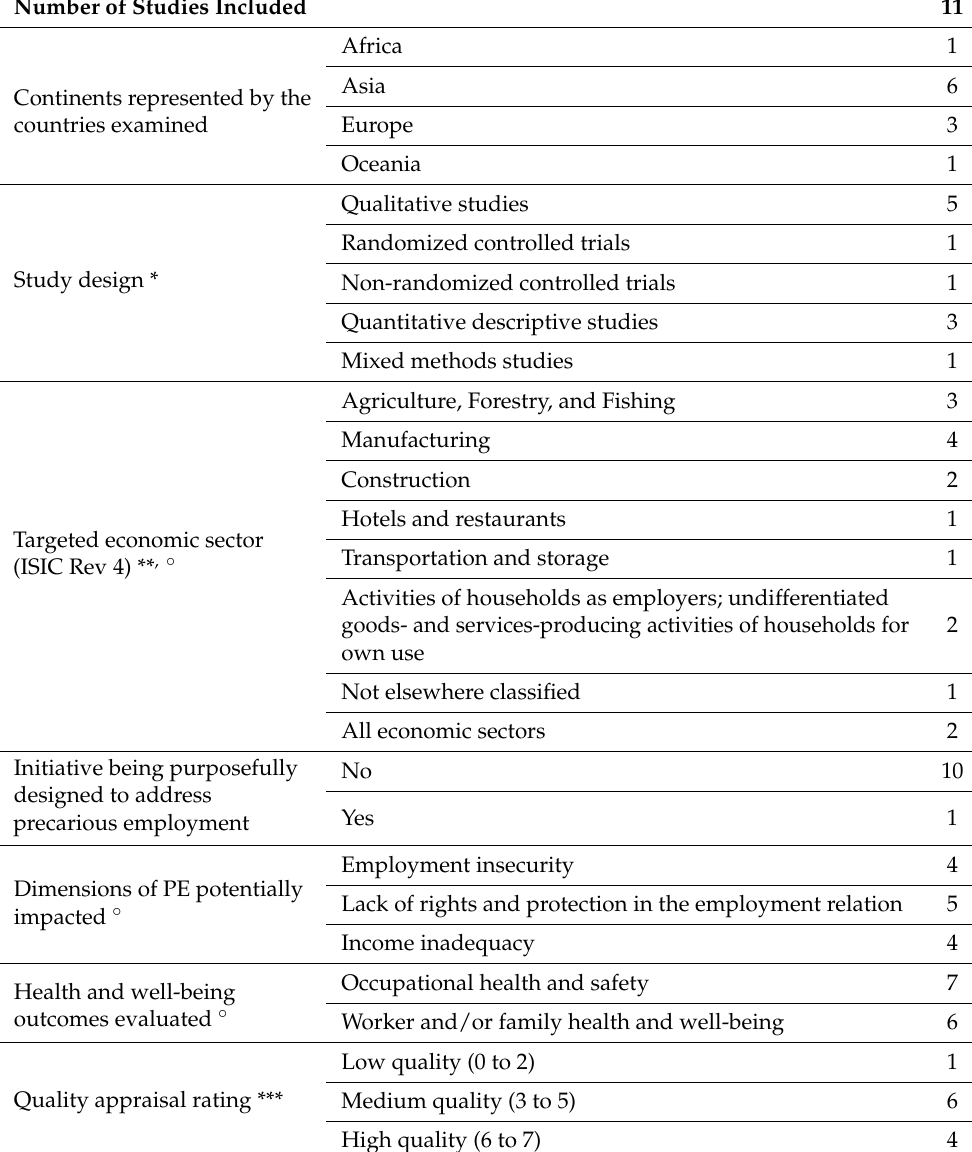
Table 1. Characteristics of the included